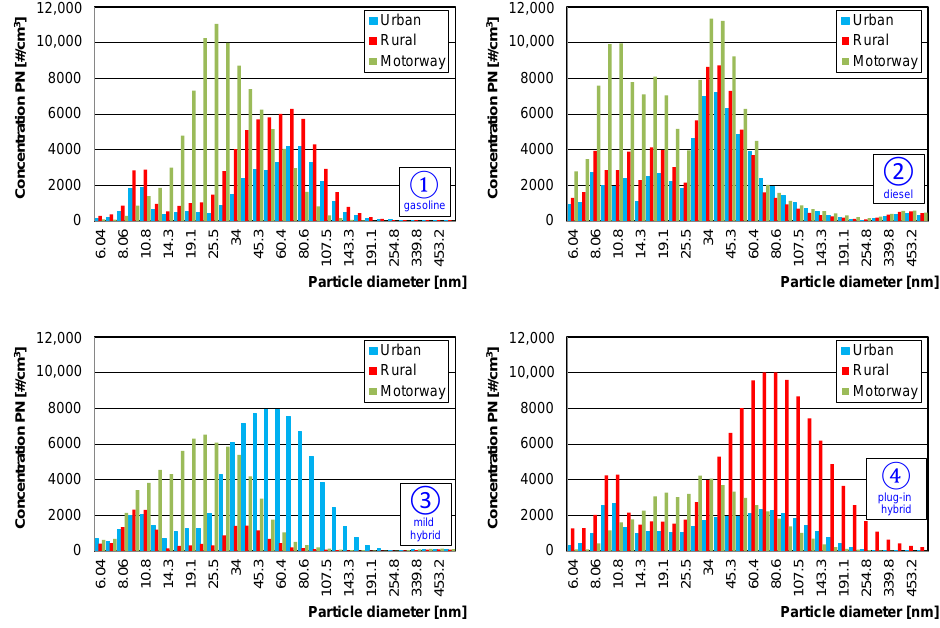
Figure 10. Dependence of particle number concentration on particle diameter for vehicles 1 – 4 in different parts of the RDE test (urban, rural, motorway); 1 — gasoline, 2 — diesel, 3 — mild hybrid, 4 — plug-in hybrid.